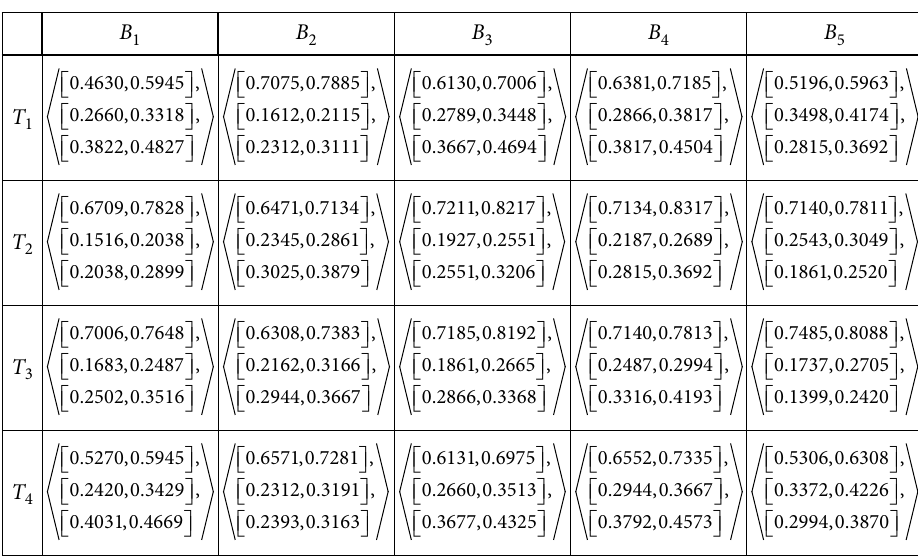
Table 7. Group decision matrix Q